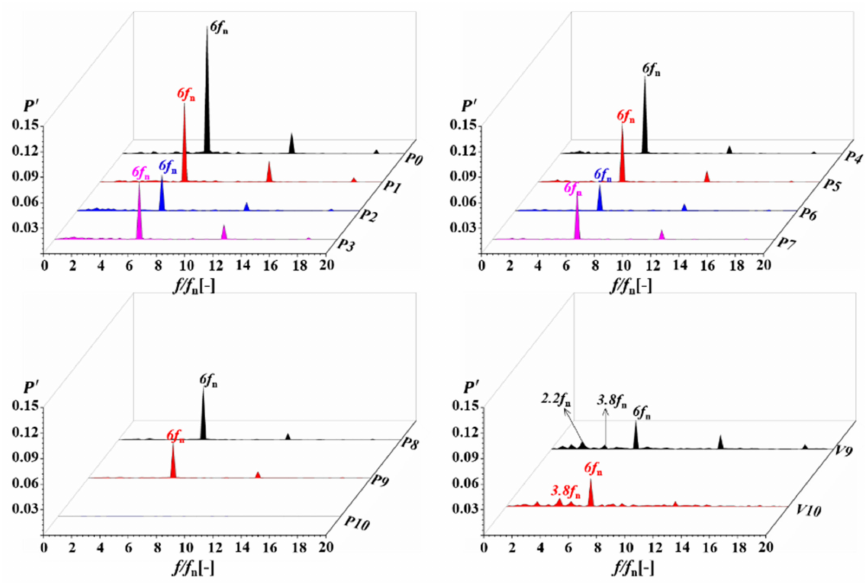
Figure 19. Frequency domain of pressure fluctuation at the 1.3 Q b operation